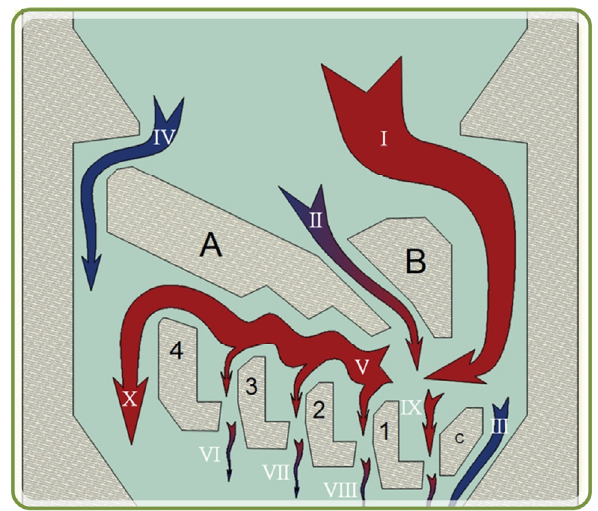
Figure 4. The trapping chamber flows schematics of the final design: ( A – C )—flow breaking structures to form main streams; 1, 2, 3, & 4—L-shaped elements for capturing a single cell and holding it during the analyses of single RBC responses to a solution/object/stimuli; I–IX—flow streams. IV—the top by-passing collateral flow, II—the local turbulence flow that creates inertia moment pushing the cells towards the traps; III and IV—valve-like streams which dump excessive pressure; I—main inflow (red arrow); VI, VII, VIII, IX—weak flows to insure single cell will flow into the trap and stay there; X—main flow that passes traps and meets collateral flow IV and creates the main flow that goes into the next